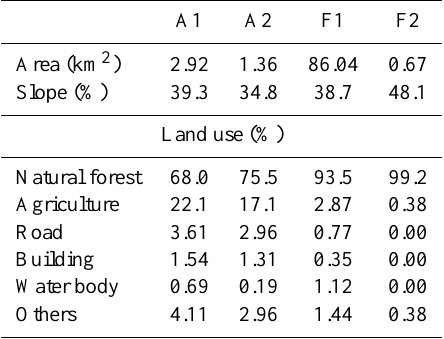
Table 1. Basic information of the studied